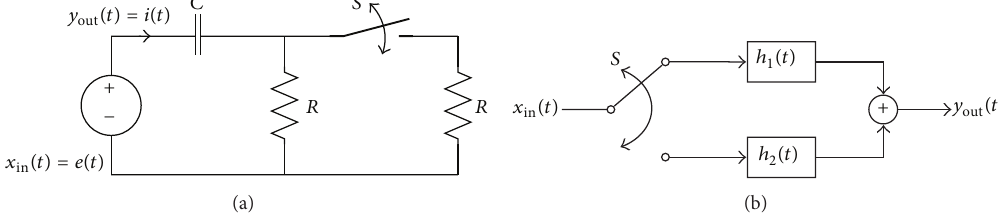
Figure 1: (a) Example time-varying circuit; (b) system equivalent defined in terms of two LTI blocks (viz. ℎ 1 and ℎ 2 ) and one switch.